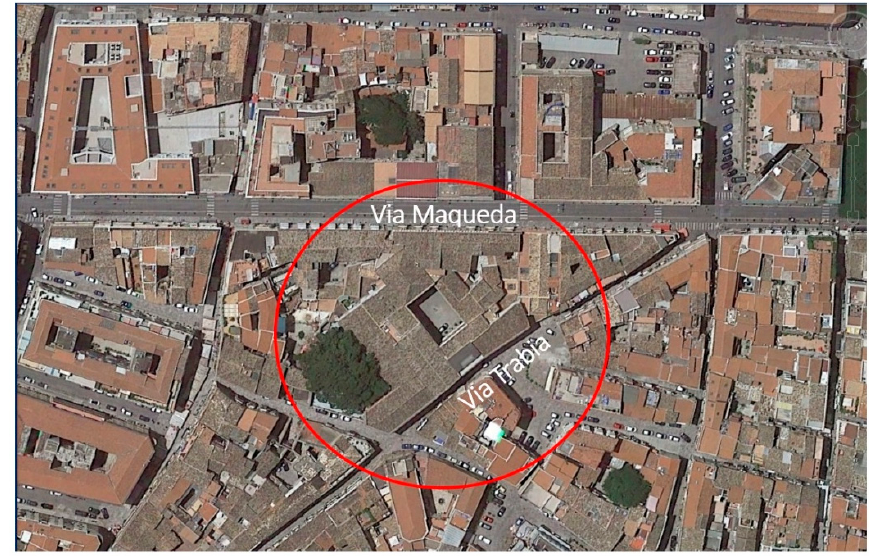
Figure 1. Palazzo Scordia. Manipulation of a Google Earth image.